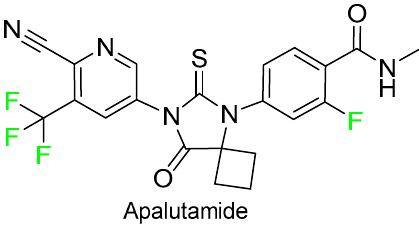
Figure 12. Structure of apalutamide.